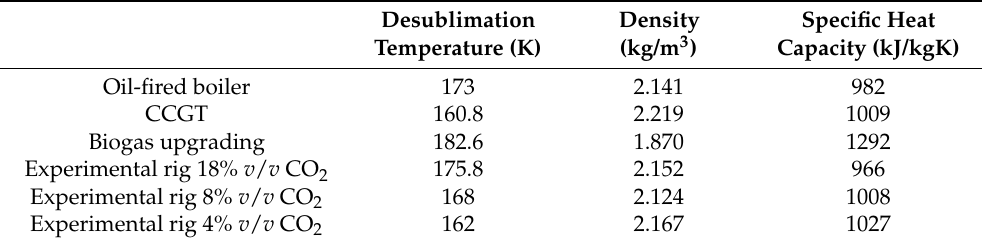
Table A1. Simulated applications and calculated densities and specific heat capacities from